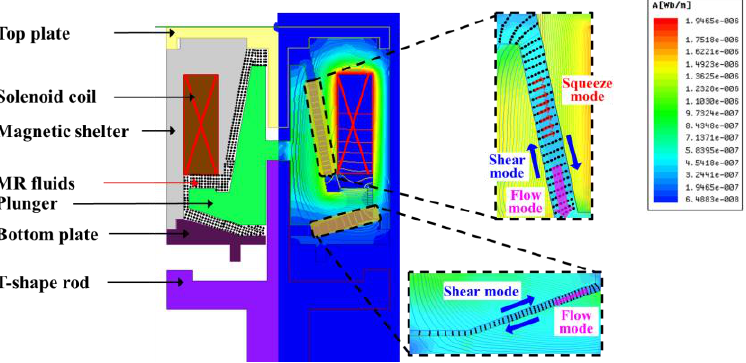
Figure 4. Cross-sectional view of the force generating part and its simulation result.